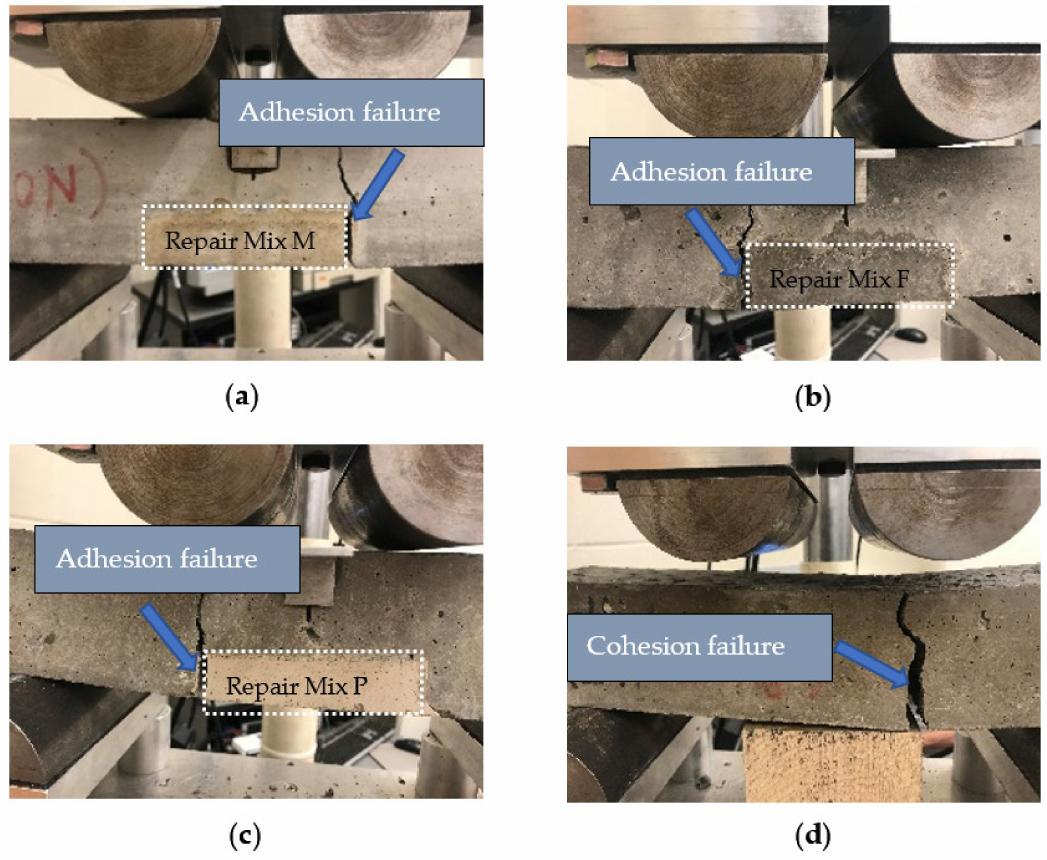
Figure 10. Failure mode under cyclic loading of ( a ) Mix M repaired specimen ( b ) Mix F repaired specimen ( c ) Mix P repaired specimen ( d ) Control Mix S specimen.